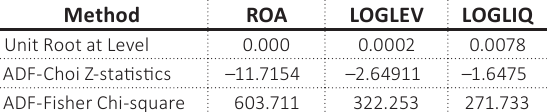
Table 2. Unit root test